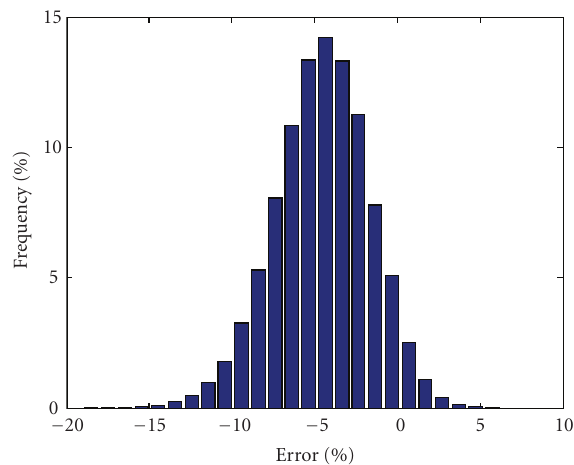
Figure 2: Trip setpoint error distribution for a selected core